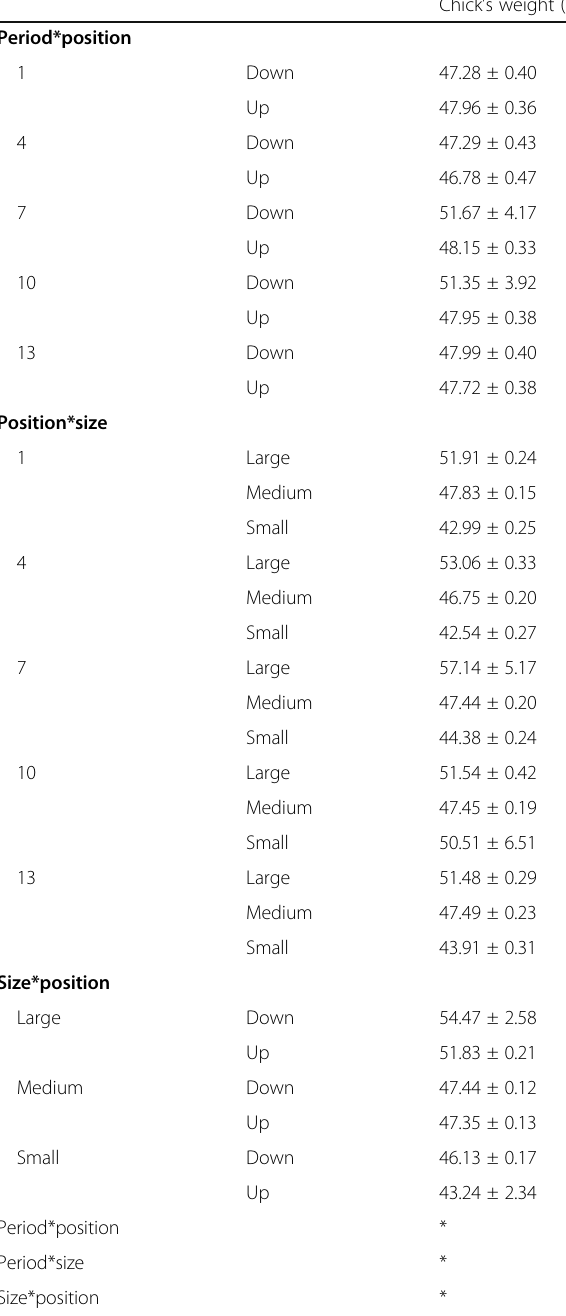
Table 3 Effects of the storage period, egg size, and egg position on chick ’ s weight